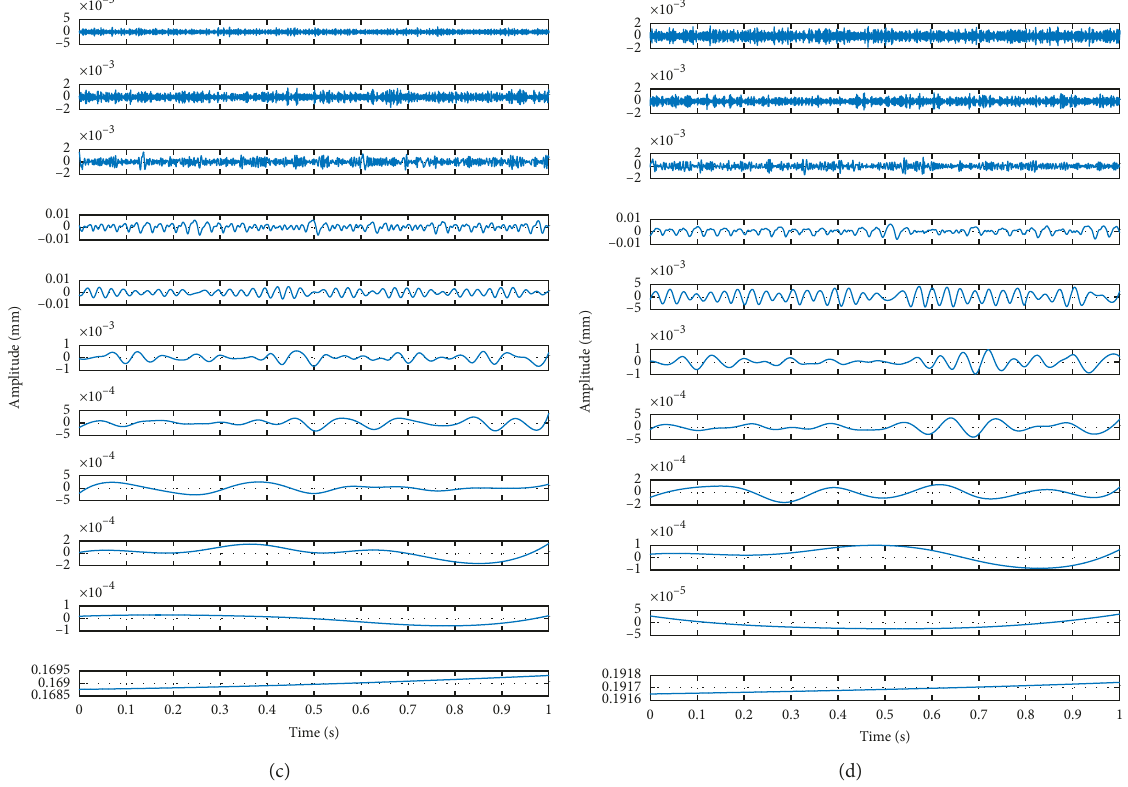
Figure 7: EEMD decomposition results of vibration signals in 4 working states. (a) Normal condition. (b) Outer ring fault. (c) Inner ring fault. (d) Cage split.